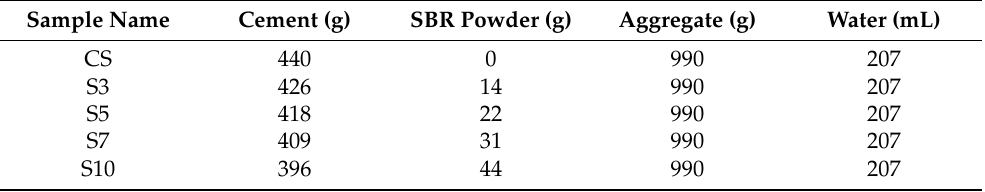
Table 4. Alkali-Silica Reaction Test: Mix Proportions and Expansions (ASTM C490 and ASTMC1260).